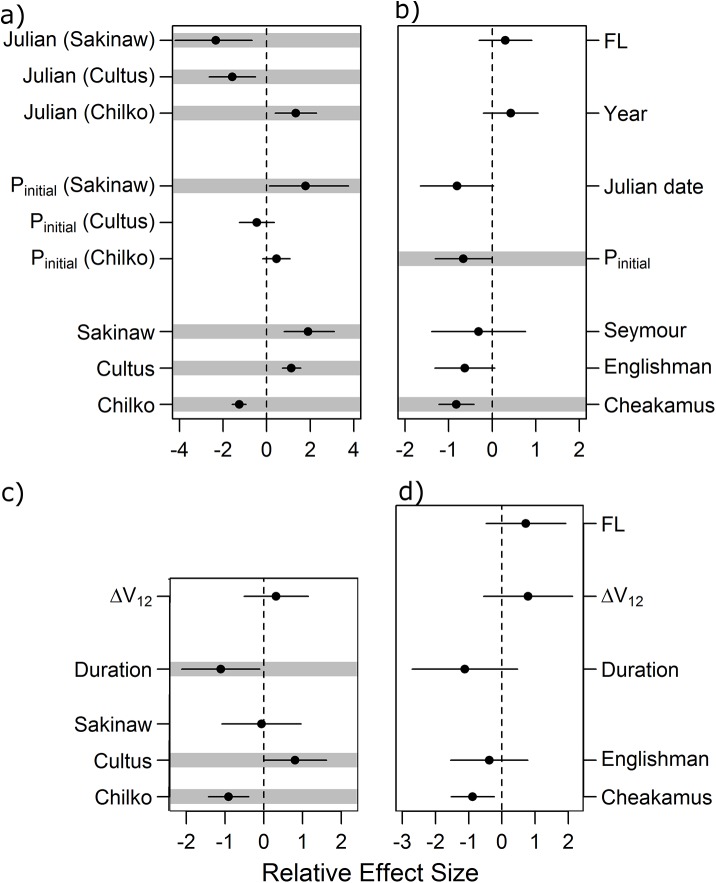
Relative effect sizes of model-averaged coefficients from general linear models (GLMs).Grey bars indicate variables for which the 95% confidence interval of the effect size does not include zero. As described in the Materials and Methods, separate models for each species were created using all smolts detected at the NSOG array (sockeye “a”, steelhead “b”), and for smolts detected for multiple periods at the NSOG array (sockeye “c”, steelhead “d”).